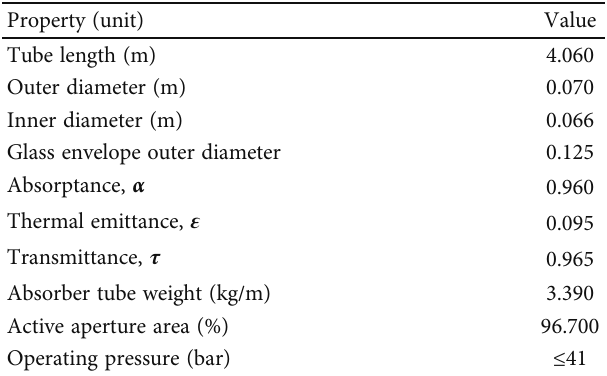
Table 3: Technical speci fi cations for the absorber tube [46, 47].